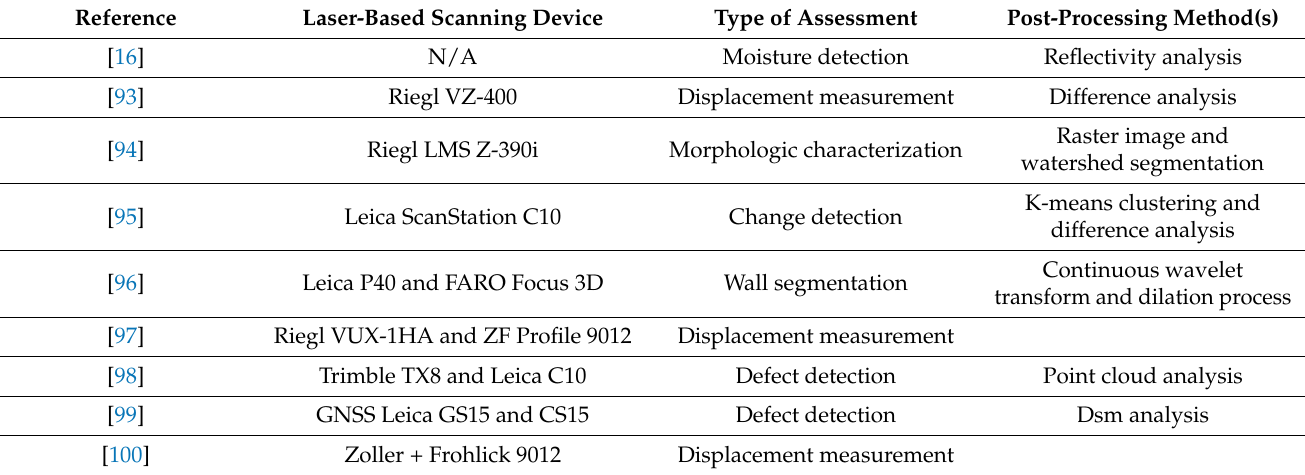
Table 7. A comprehensive summary of laser-based assessment techniques for retaining